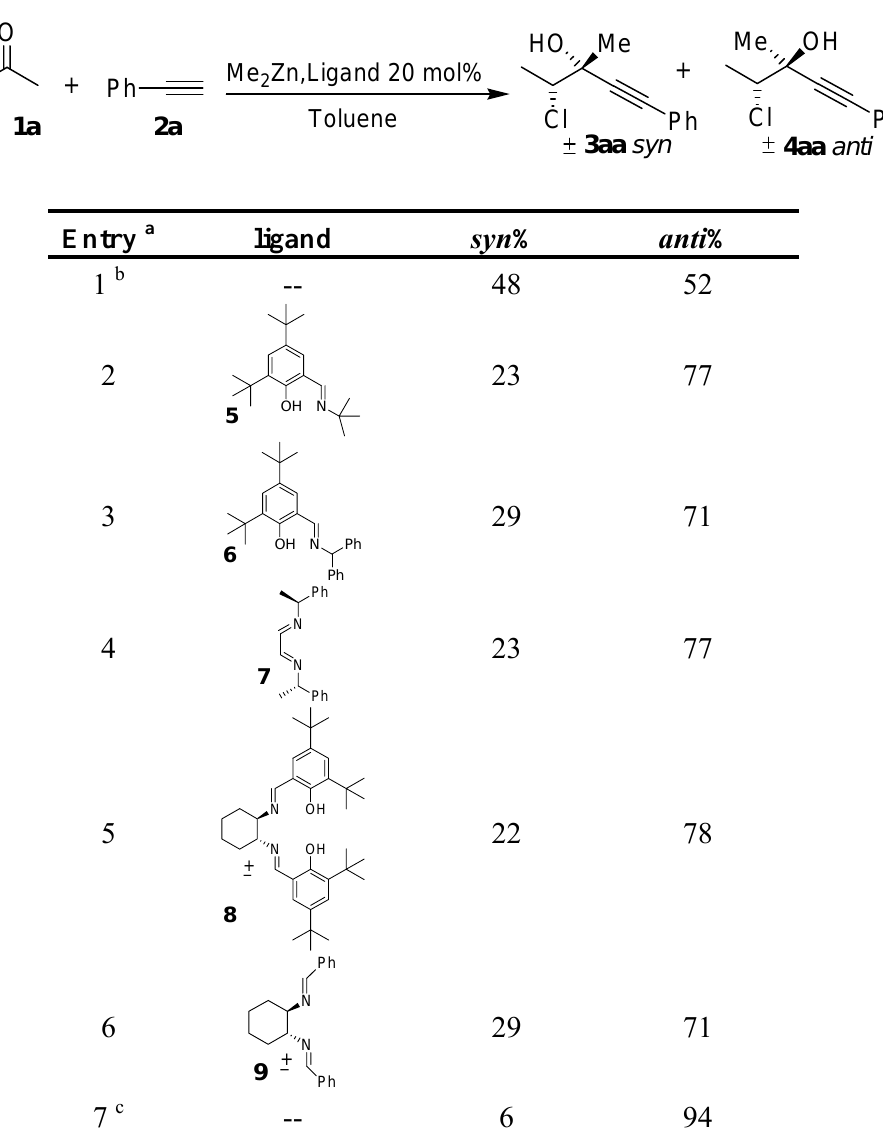
Table 1. Diastereoselective addition of phenylacetylene in the presence of